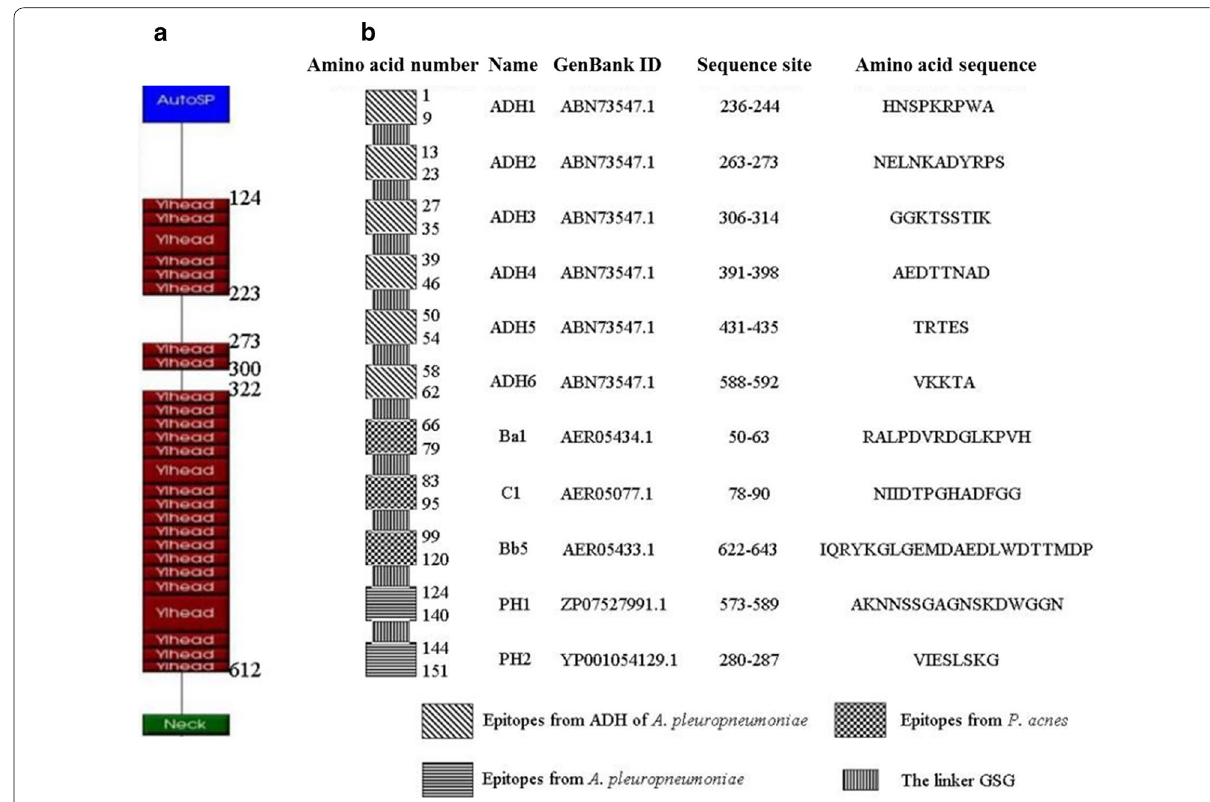
Fig. 1 Structural information for the rta gene. a The composition of ADH was analyzed with daTAA software. b Information on the rta gene. The epitopes of ADH were predicted by DNASTAR and BepiPred 1.0 software and successively connected with Ba1, C1, Bb5, PH1 and PH2 via a flexible linker